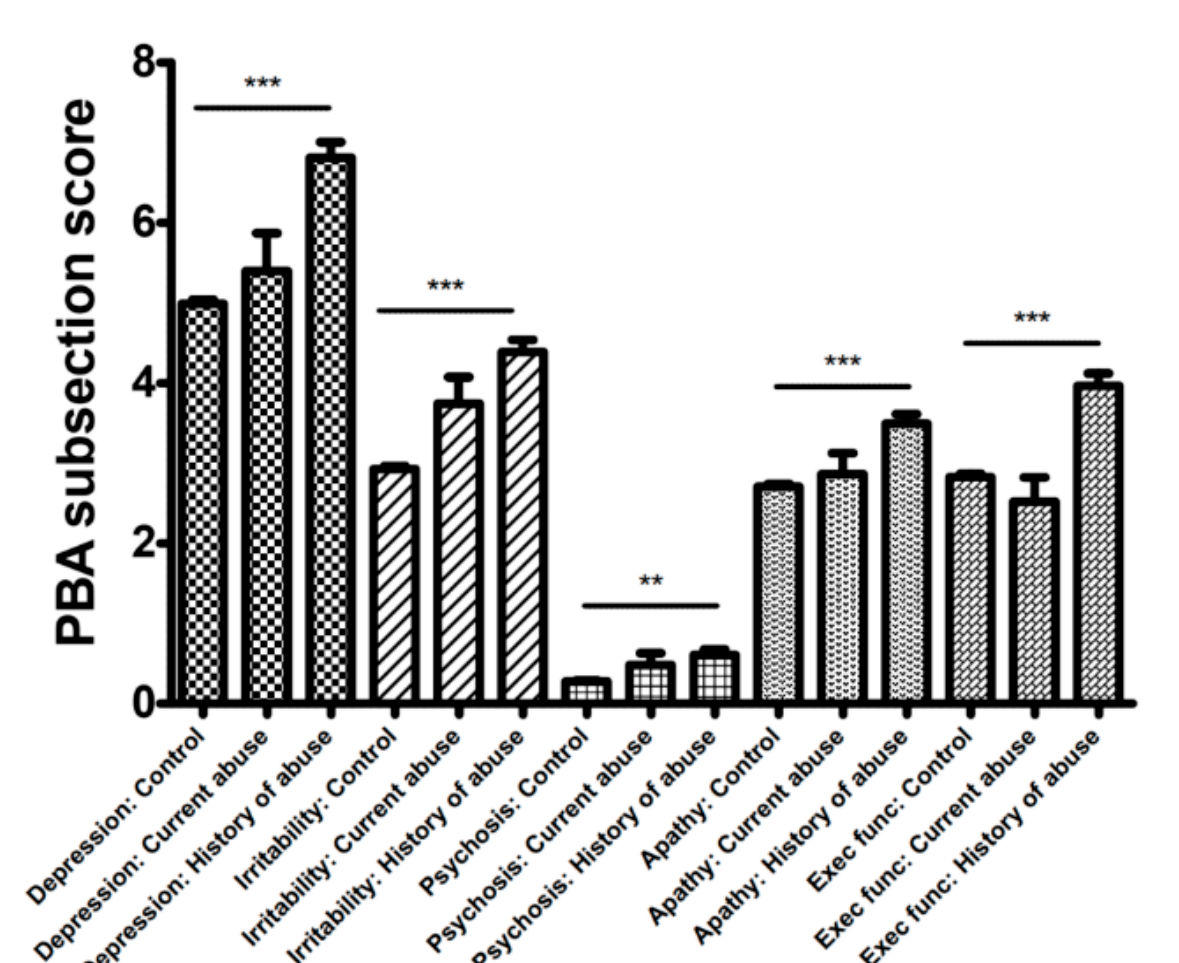
Figure 2. Problem Behaviours Assessments (PBAs) as a measure of psychiatric burden in Huntington’s Disease (HD) shows depression, apathy, irritability, psychosis and executive function are all significantly more sever when compared to controls (Kruskal Wallis, post hoc Dunn’s, p < 0.0001). p values <0.01 shown as ‘**’ and p <0.001 as ‘***’